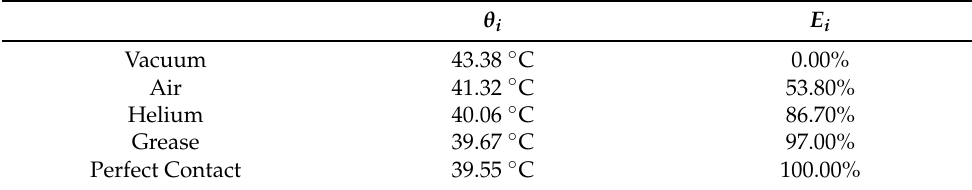
Table 9. Microelectronic packaging thermal efficiency for each TIM